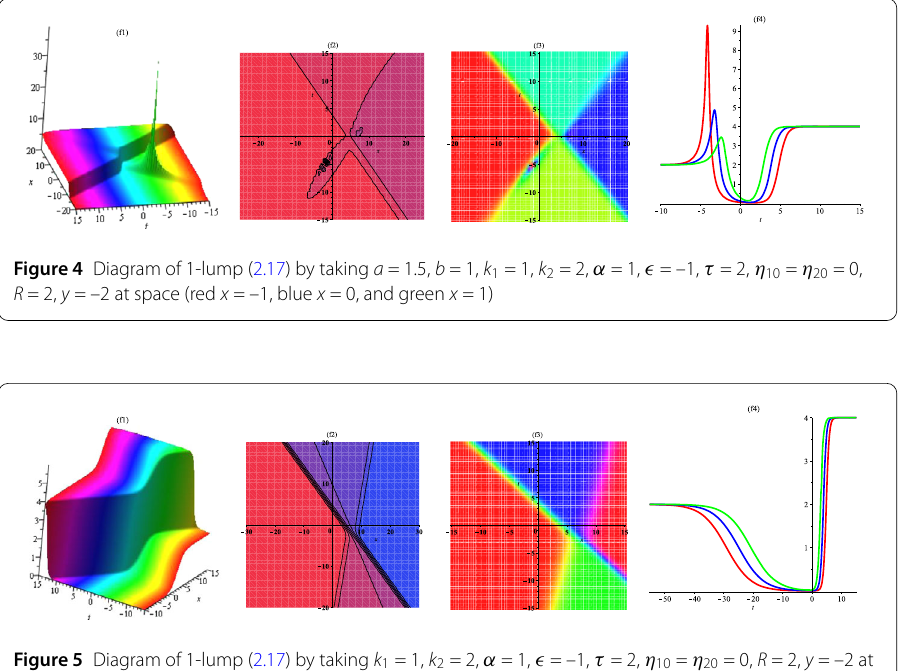
including the 3D plot, density plot, and 2D plot when three spaces arise at spaces x = –1, x = 0, and x =